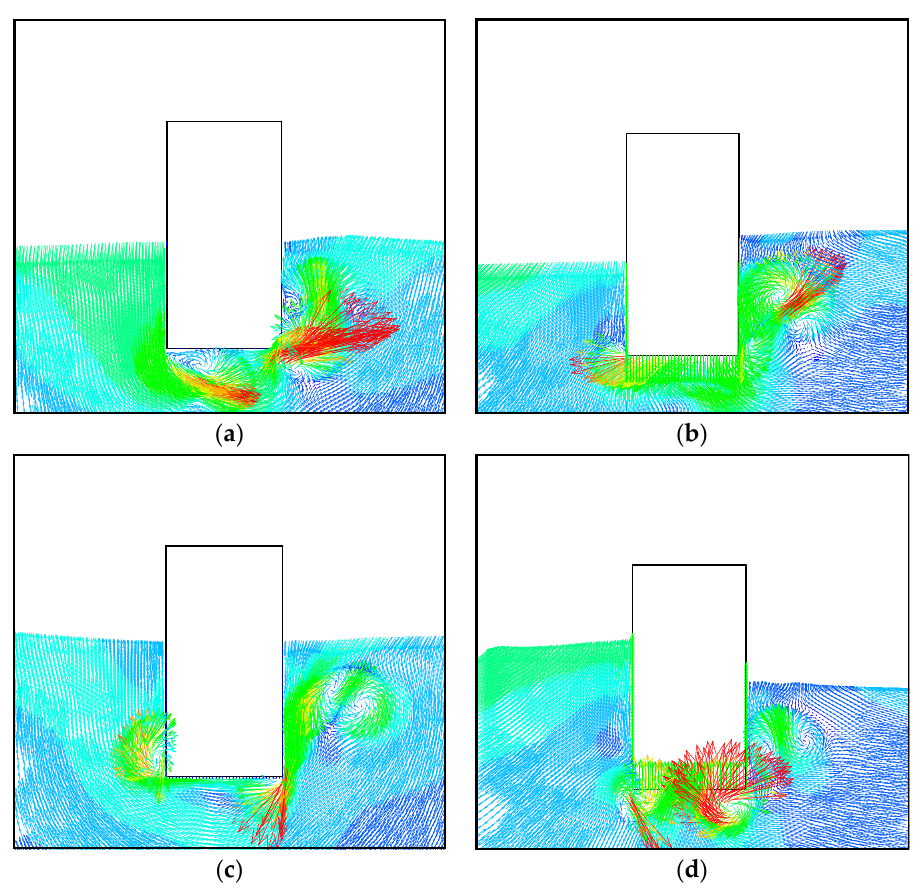
Figure 17. Flow fields around the buoy in a wave cycle ( W = 2:1, H = 0.1 m, T = 1.75 s): ( a ) t = T/4; ( b ) t = 2T/4; ( c ) t = 3T/4; ( d ) t = 4T/4.